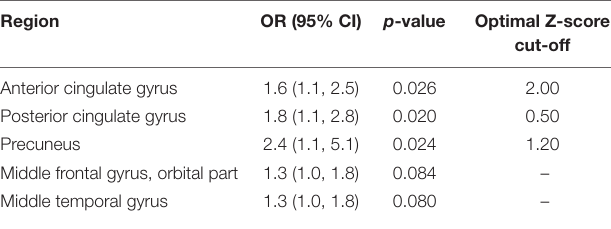
TABLE 9 | Logistic regression using regional Z-score to predict cerebrospinal fluid (CSF) A β 42 levels ( n = 51).